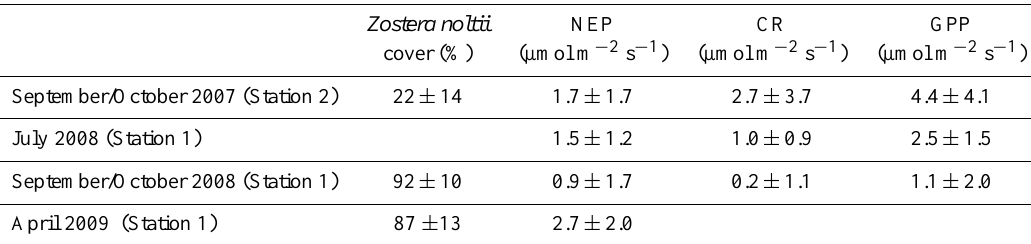
Table 3. Comparison of NEP components at low tide for the autumn season at the two stations and in summer at Station 1. NEP was assumed as NEE at low tide during daytime, CR was assumed as NEE at low tide during the night, and GPP was assumed as the sum of NEP and CR. Notice that F c values obtained in July 2008 during the beginning of the experiment (Days 183, 184) and in September–October 2008 (Day 279) have been discarded for calculations, representing destocking but not biological degassing by respiration (Figs. 5f and 6f). The GPP and CR calculations for the spring 2009 period at Station 1 were not possible because of the slight negative averaged flux value obtained at Low Tide/Night (see discussion). Zostera noltii covers for the April 2009 flux data are derived from a SPOT image from ten weeks later (26 June 2009) and are thus probably much higher than during the flux